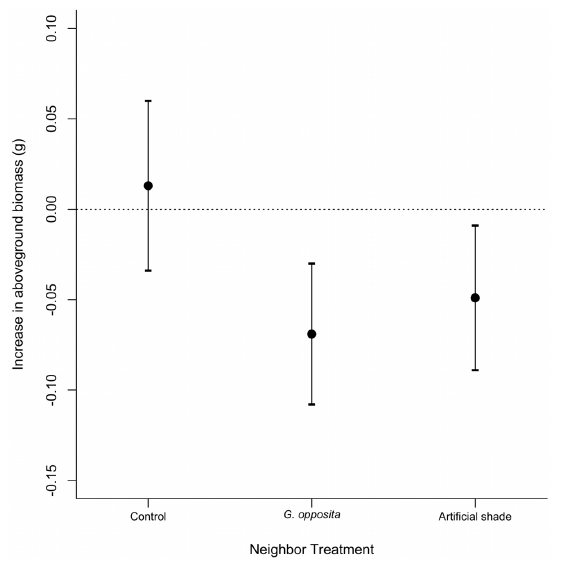
Figure 3. Growth of Ternstroemiabrasiliensis seedlings after 358 days in the three levels of the neighbor treatment (mean ± 95% confidence interval). The estimates are based in the selected model (model M3.G in Table